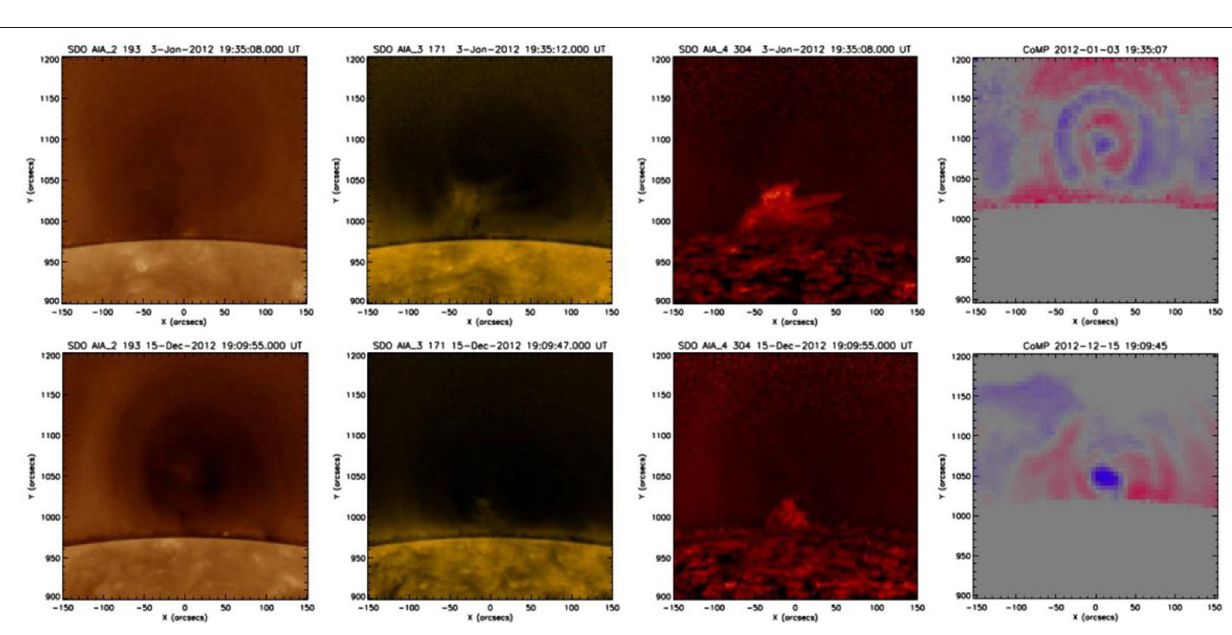
FIGURE 9 | Cavities observed on 2012 January 03 and 2012 December 15 by SDO/AIA 193, 171, 304 Å, and CoMP. Those images show that central flows are systematically located above the prominences and they are spatially correlated with the cavity